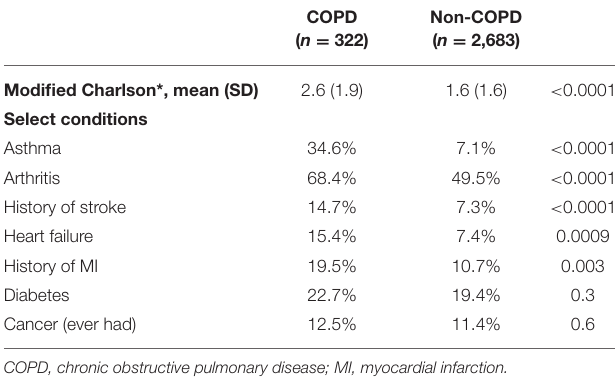
COPD, chronic obstructive pulmonary disease; MI, myocardial infarction. * Modified Charlson co-morbidity index: as previously described in the NSHAP data set based on the original index of 19 weighted conditions; co-morbidities were added with varying weights as follows: 1 point assigned to history of myocardial infarction, gastric ulcer disease, congestive heart failure, peripheral vascular disease, arthritis, dementia, asthma, and stroke; 1.5 points assigned to diabetes, 2 points assigned to liver disease, leukemia, lymphoma, renal disease, and cancer history; and 6 points assigned to metastatic cancer. COPD was removed from the score. Possible score ranged from 0 to